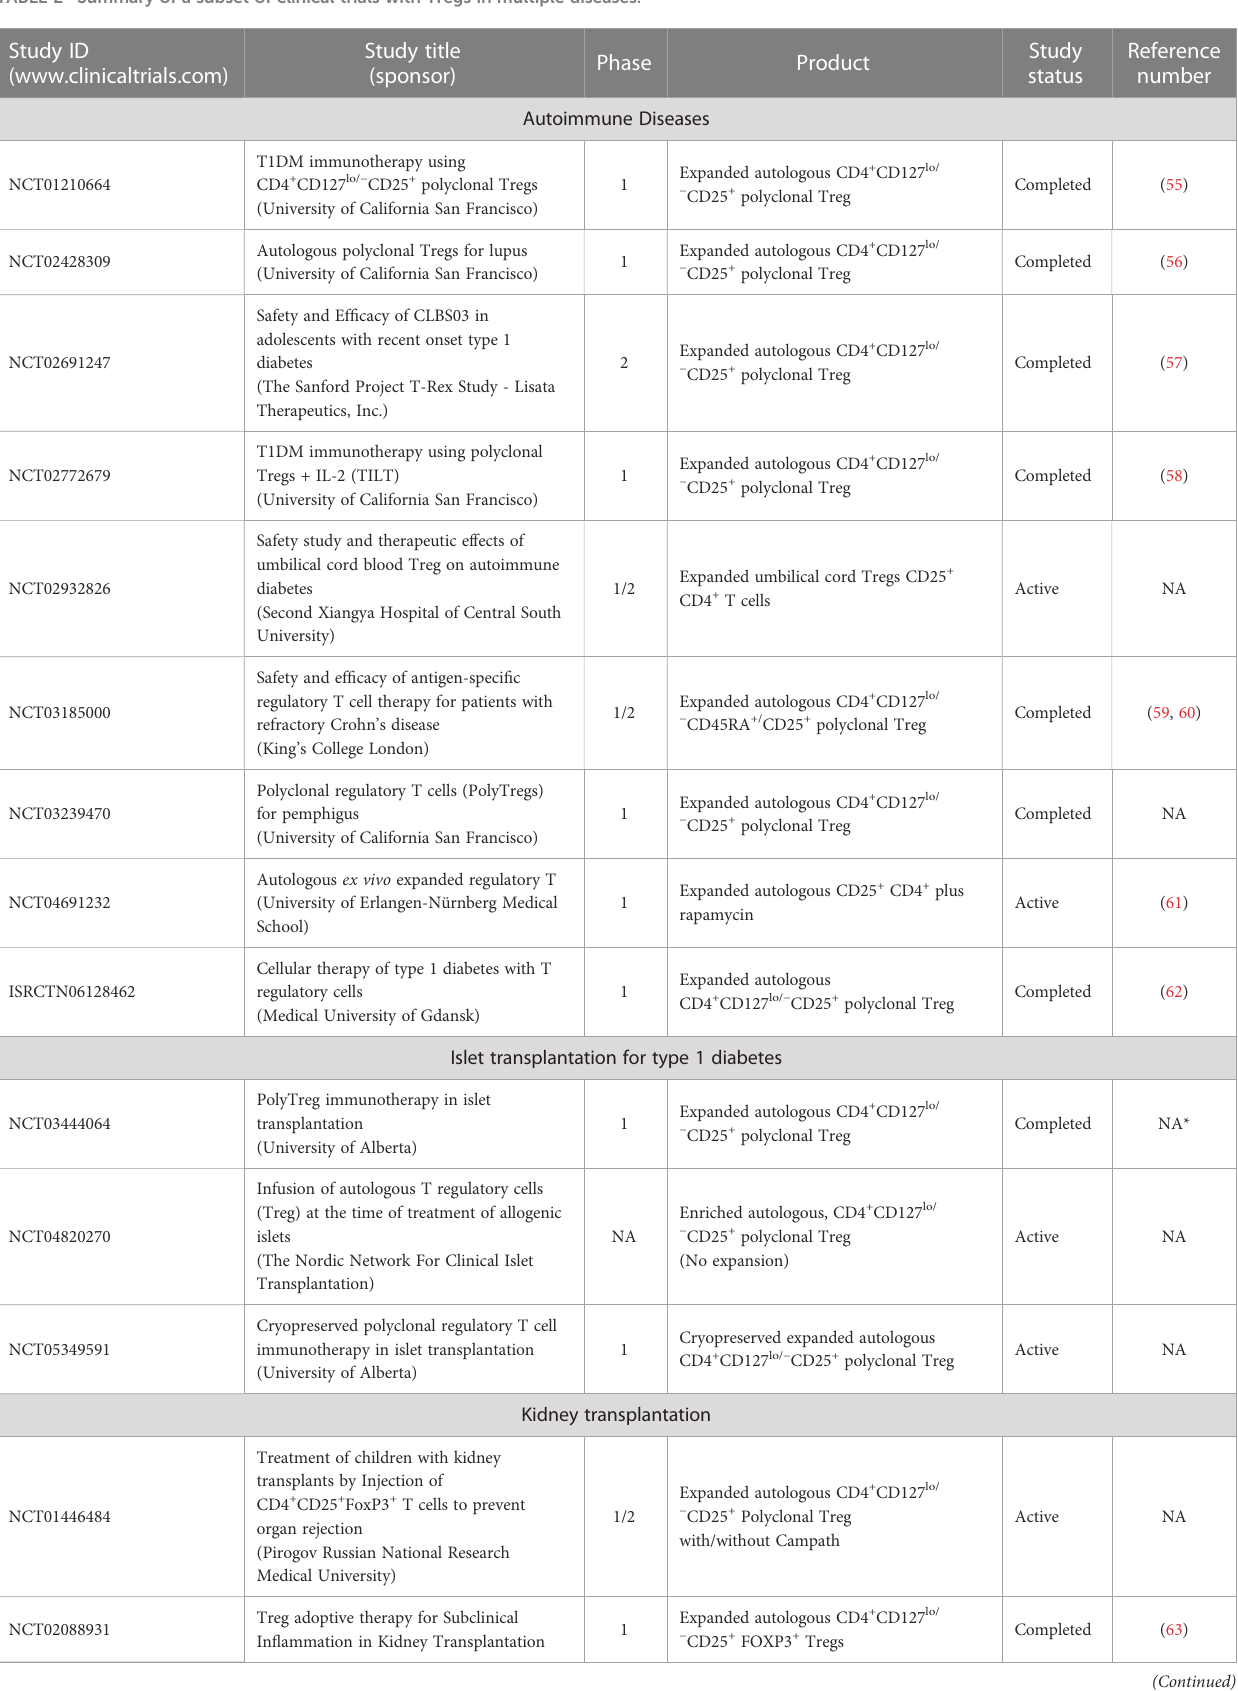
TABLE 2 Summary of a subset of clinical trials with Tregs in multiple diseases. Study ID